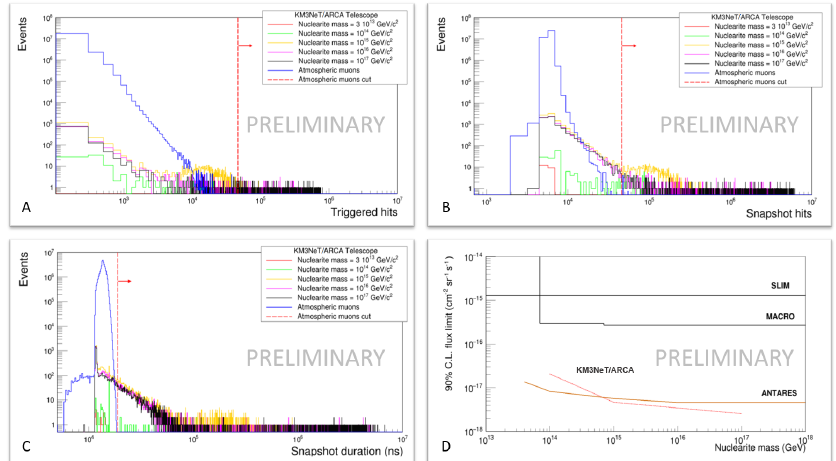
Figure 1. (A) Triggered hits, (B) Snapshot hits and (C) Snapshot duration distributions for nucle- arites and atmospheric muons, with optimized cuts through MRF. (D) Preliminary sensitivity results of KM3NeT / ARCA detector to nuclearite signal compared to MACRO [4] and SLIM [5] upper limits and ANTARES [6] sensitivity for 839 days of 2009-2017